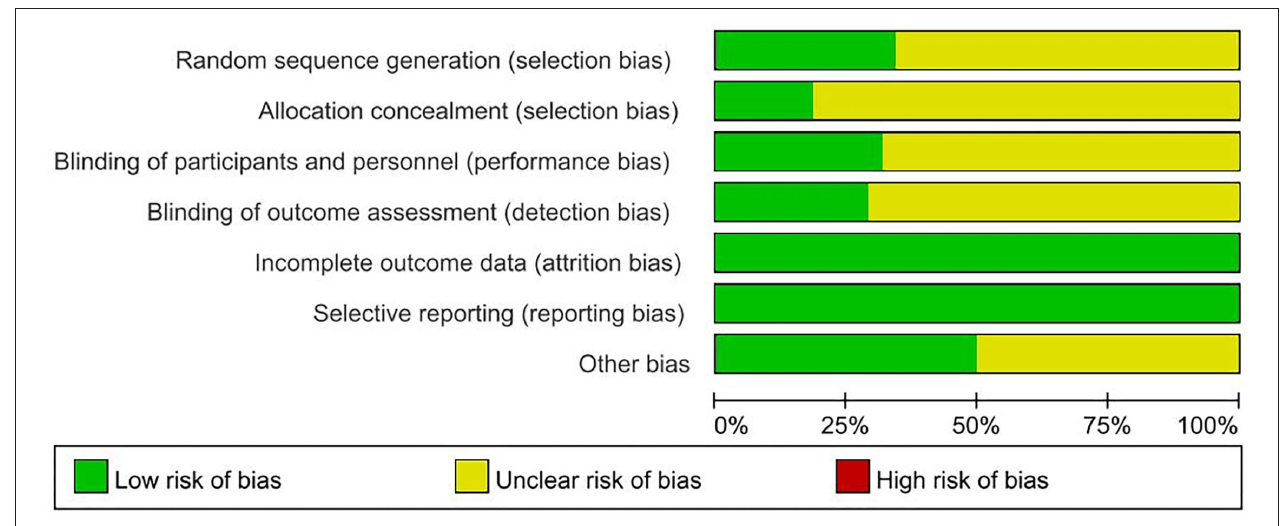
FIGURE 2 | Risk of bias graph of 73 included